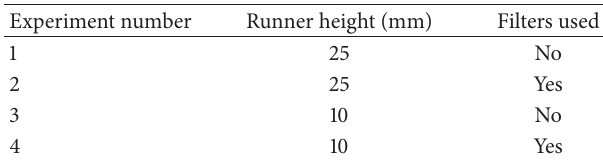
Table 2: Experimental